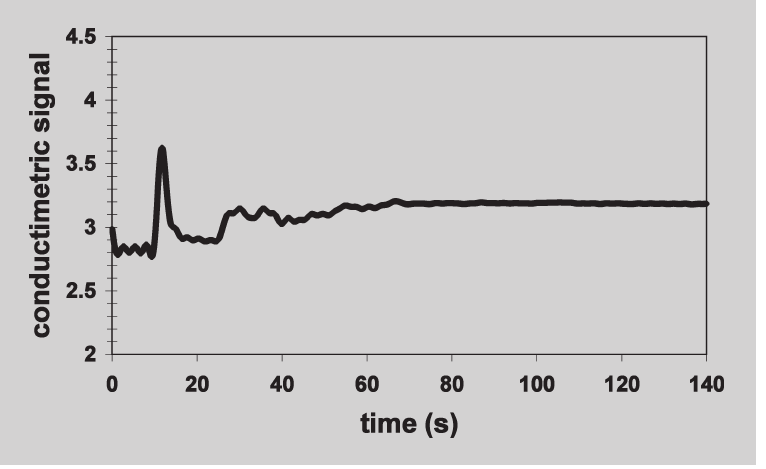
Figure 6: Conductivity signal curve during the mixing of 1 ml saturated salt solution (1.2 mPas) injected in 60 ml of glucose solution (here 1.6